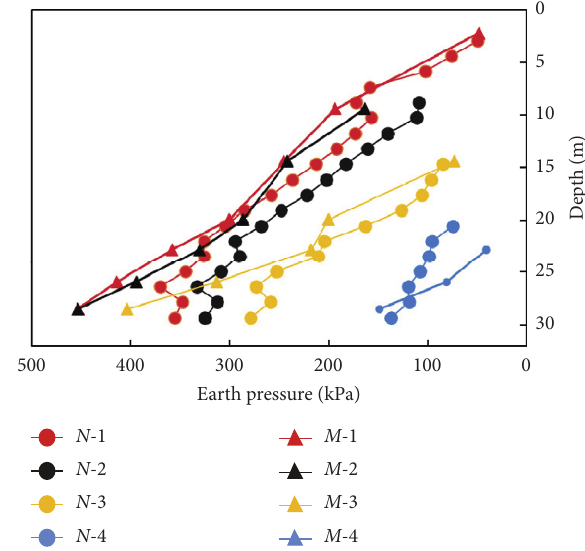
Figure 11: Earth pressure in front of the wall of 0.4H.